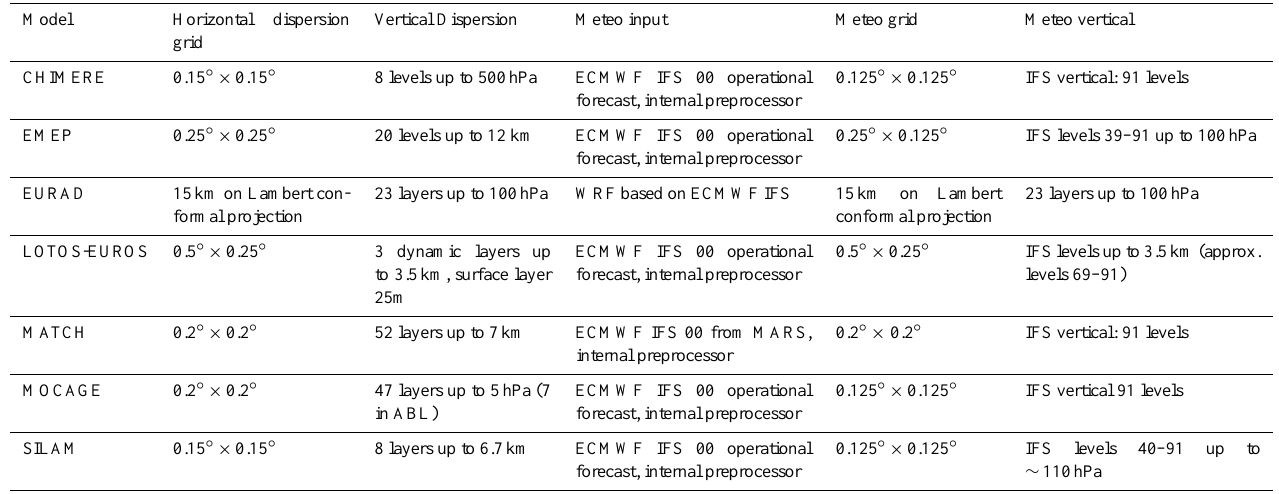
Table 1. Setup of the simulations for the participating models.